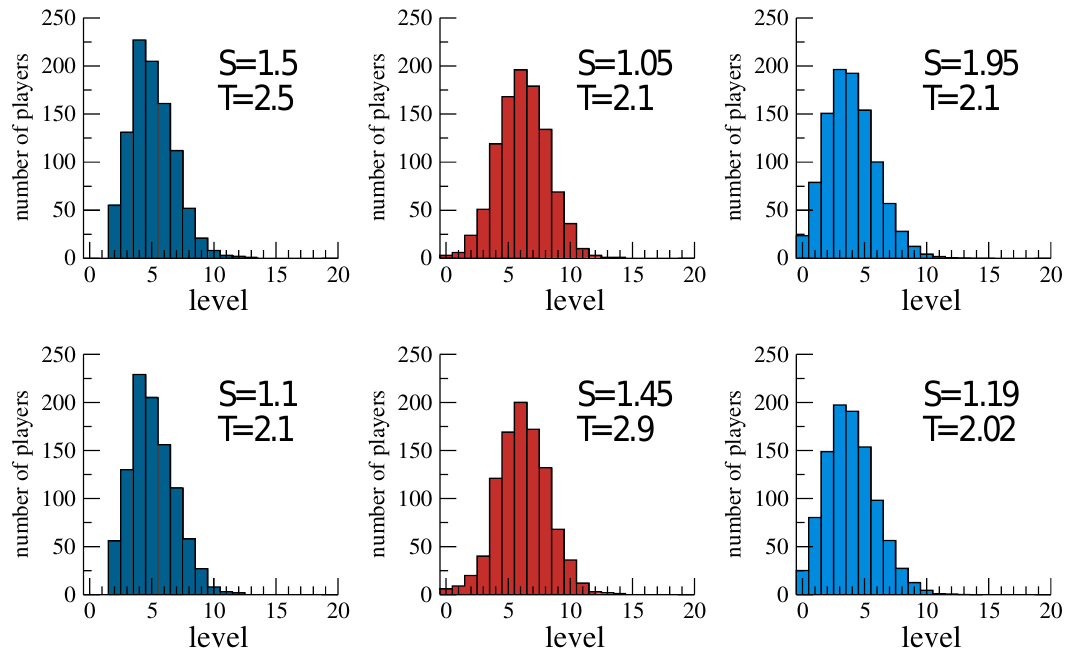
Figure 3. Histograms of the cognitive levels of the population in the stationary state of the dynamics of the SG game in Scenario A. Panels in the same vertical correspond to games in the same equivalence class m . The values of the game parameters T and S are shown inside the corresponding panel.